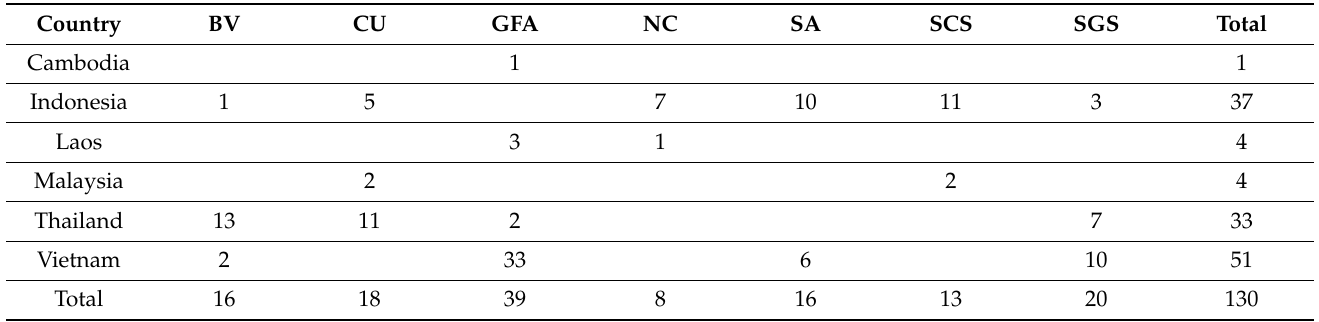
Table 2. Certification holders amounts presented between per